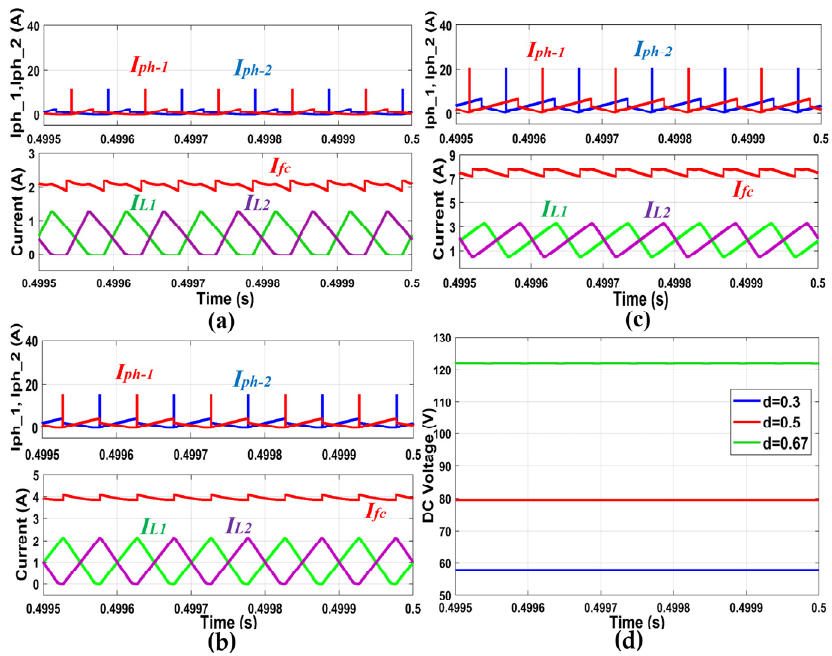
Figure 5. IHGBC simulation results: (a), (b) and (c) show the input current, phase currents and inductor currents at duty cycle values of 0.3, 0.5, and 0.67, respectively. While (d) the obtained output voltage values.